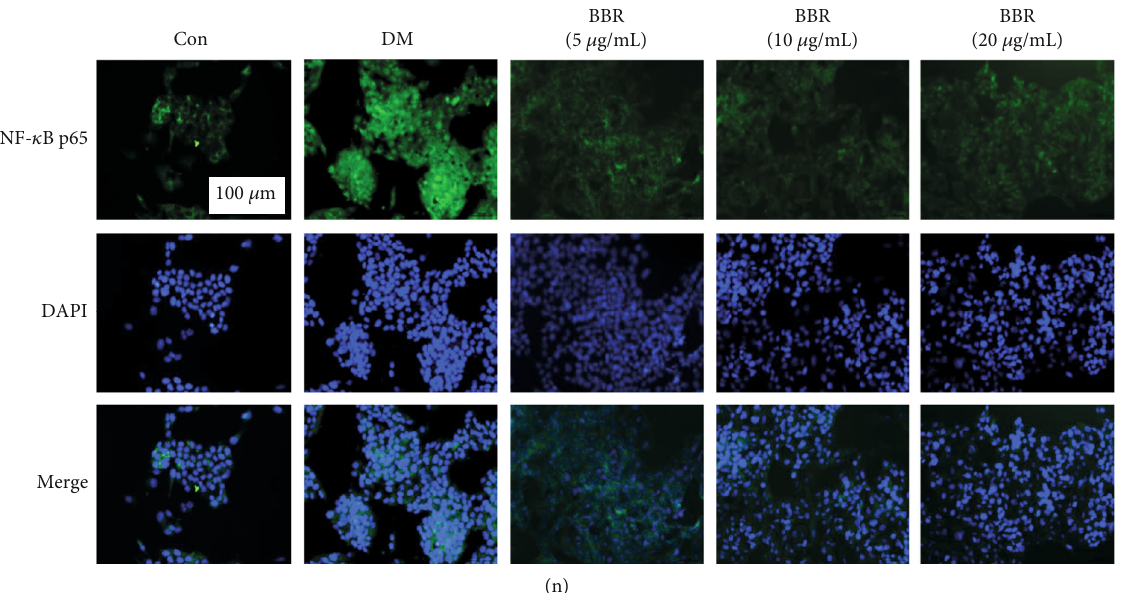
Figure 8: E ff ect of BBR on the protein expression level of targets in the PPM1B pathway in HepG2-IR cells. (a) Representative Western blotting results of targets. (b – i) Semiquantitative analysis of PPM1B, LRP1, pIKK β Ser181, GLUT4, PPAR γ , IKK β , NF- κ B p65, and JNK in liver tissues. The experiments were repeated three times and presented as mean ± SD . ▲ P < 0 : 05 and ▲▲ P < 0 : 01 , Con vs. model; ∗ P < 0 : 05 and ∗∗ P < 0 : 01 , model vs. BBR-treated groups. The HepG2-IR cells under the indicated treatment were costained by (j) PPM1B (green) and PPAR γ (red) immuno fl uorescence antibody, as well as (k) LRP1 (green), (l) GLUT4 (green), (m) IKK β (green), and (n) NF- κ B p65 (green). DAPI (blue) was used to visualize nuclei. Representative microscopic pictures are shown. Magni fi cation, × 100. Scale bar, 100 μ m. The experiments were replicated at least three